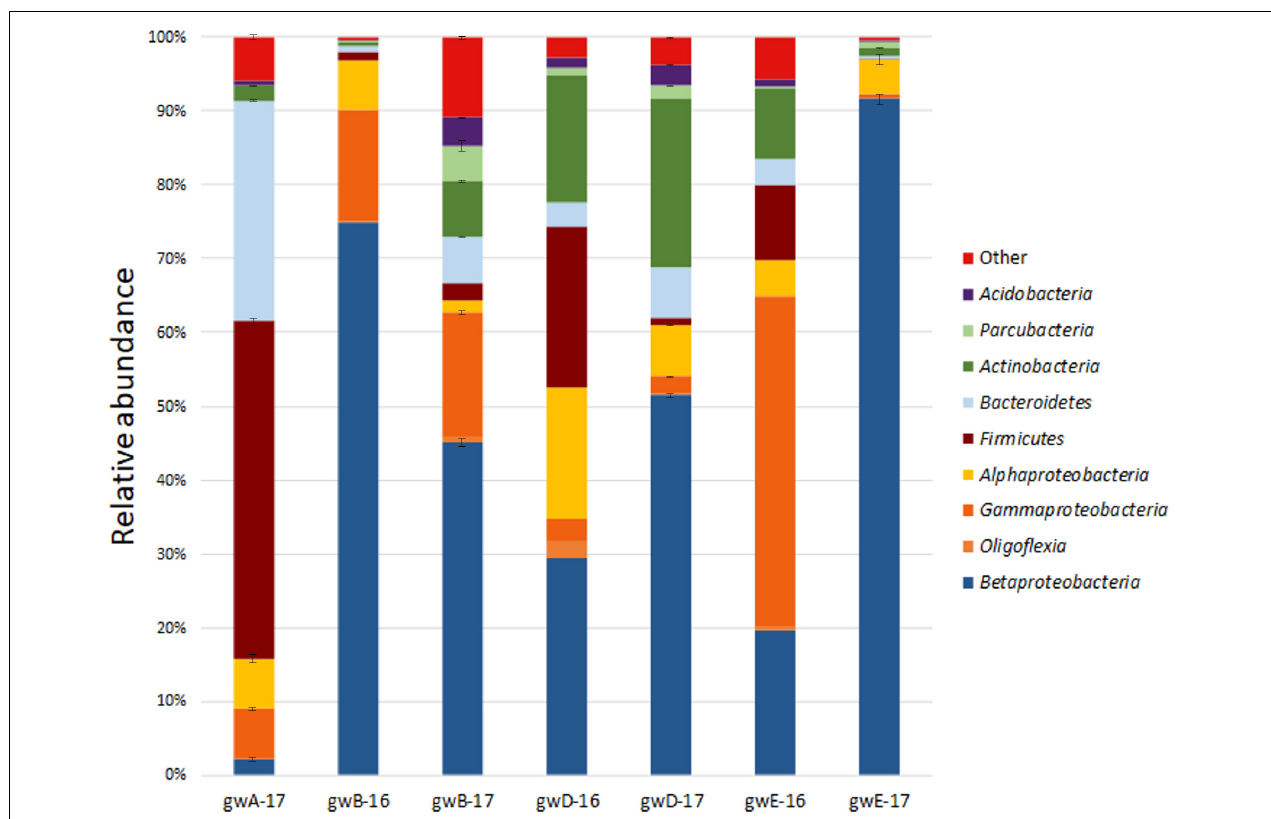
FIGURE 2 | Taxonomic classification of bacterial 16S rRNA gene fragments in the libraries from groundwater samples at the phylum level (at the class level for Proteobacteria ) using the RDP classifier.